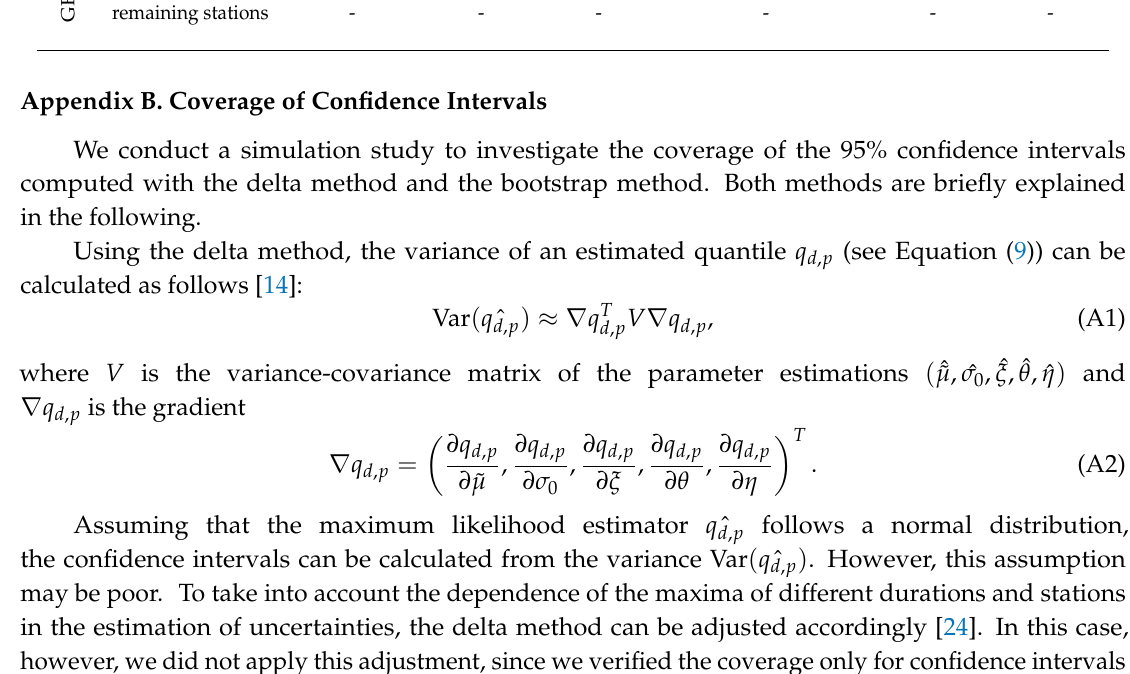
Table A1. Cross-validation sets used for training and validating the spatial d-GEV and the reference model (GEV). N represents the complete length of the time series and varies for different durations and stations, while n train is a fixed number of years for each time series. Overall Performance Dependence on Time Series Length Ungauged Sites Training Validation Training Validation Training Validation V station ( N − 3) years 3 years n train years 3 years - 3 years remaining stations all data - all data - all data - V station ( N − 3) years 3 years n train years 3 years n train years 3 years E remaining stations - - - - - G